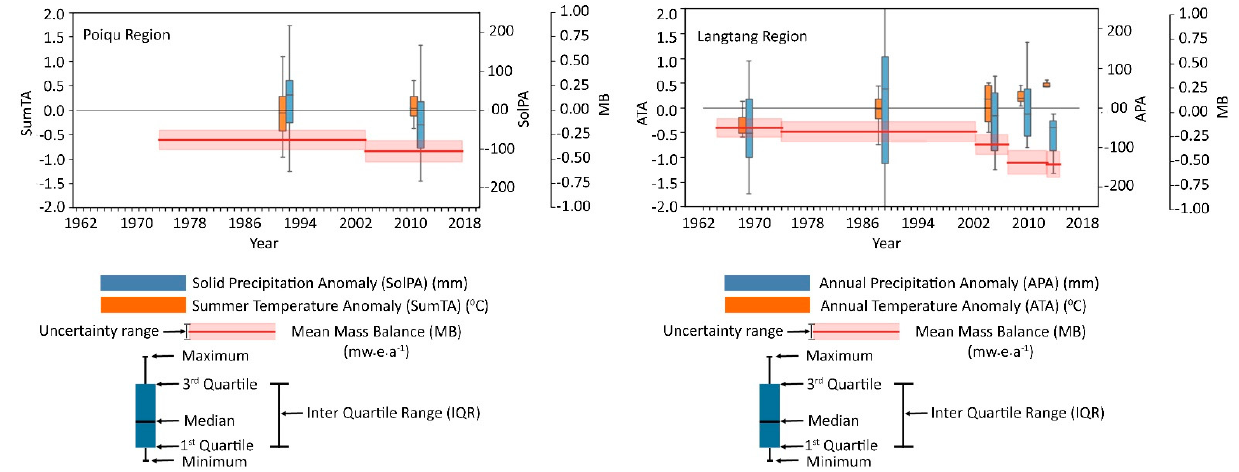
Figure 7. Comparison of average annual mass change rate of glaciers for the whole Poiqu Region with ERA5 Land climate variables and the mass change of the Langtang Basin with measurements at Nielamu station (adjusted based on Bhattacharya et al. 2021) [47]. The analysis of the climate data also hint at extended ablation seasons. For the Mt Everest region, which has similar climatic and glaciological characteristics (Pelto et al., 2021), [85] found ablation seasons extending into mid-winter, as indicated by rising snow lines in recent years from October to January. These warmer post-monsoon and earl- win- ter periods can lead to significant sublimation, and hence increased mass loss (Potocki et al., 2022) [86]. The changes in temperature and precipitation correlate moderately (r 2 0.61–0.69) with glacier mass balance but do not explain the full variance of glacier mass budgets.